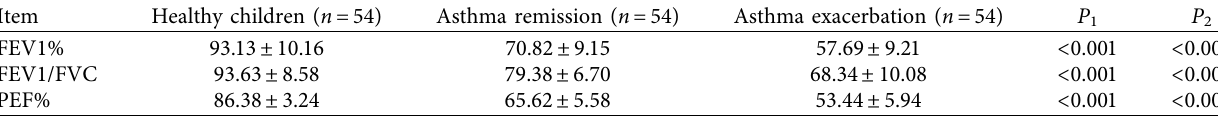
Table 1: The FEV1%, FEV1/FVC, and PEF% of asthma exacerbation children, asthma remission children, and healthy children.